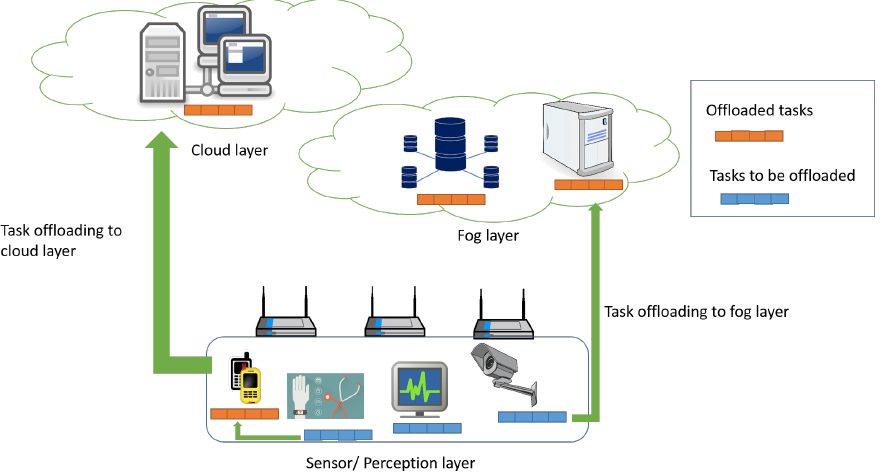
Figure 3. Offloading strategies using fog-computing paradigm. The fog layer is composed of cloudlets (small-scale data centers),and storage (fog servers). The cloud layer houses data centers and